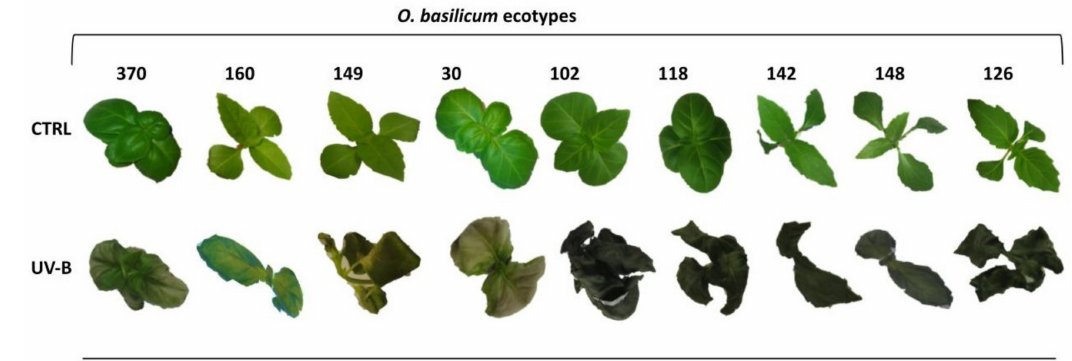
Figure 1. Appearance of nine different O. basilicum ecotypes over 48 h, after UV-B exposure (68 kJ m − 2 day − 1 ) and control (Ctrl) condition (not UV-B exposed).